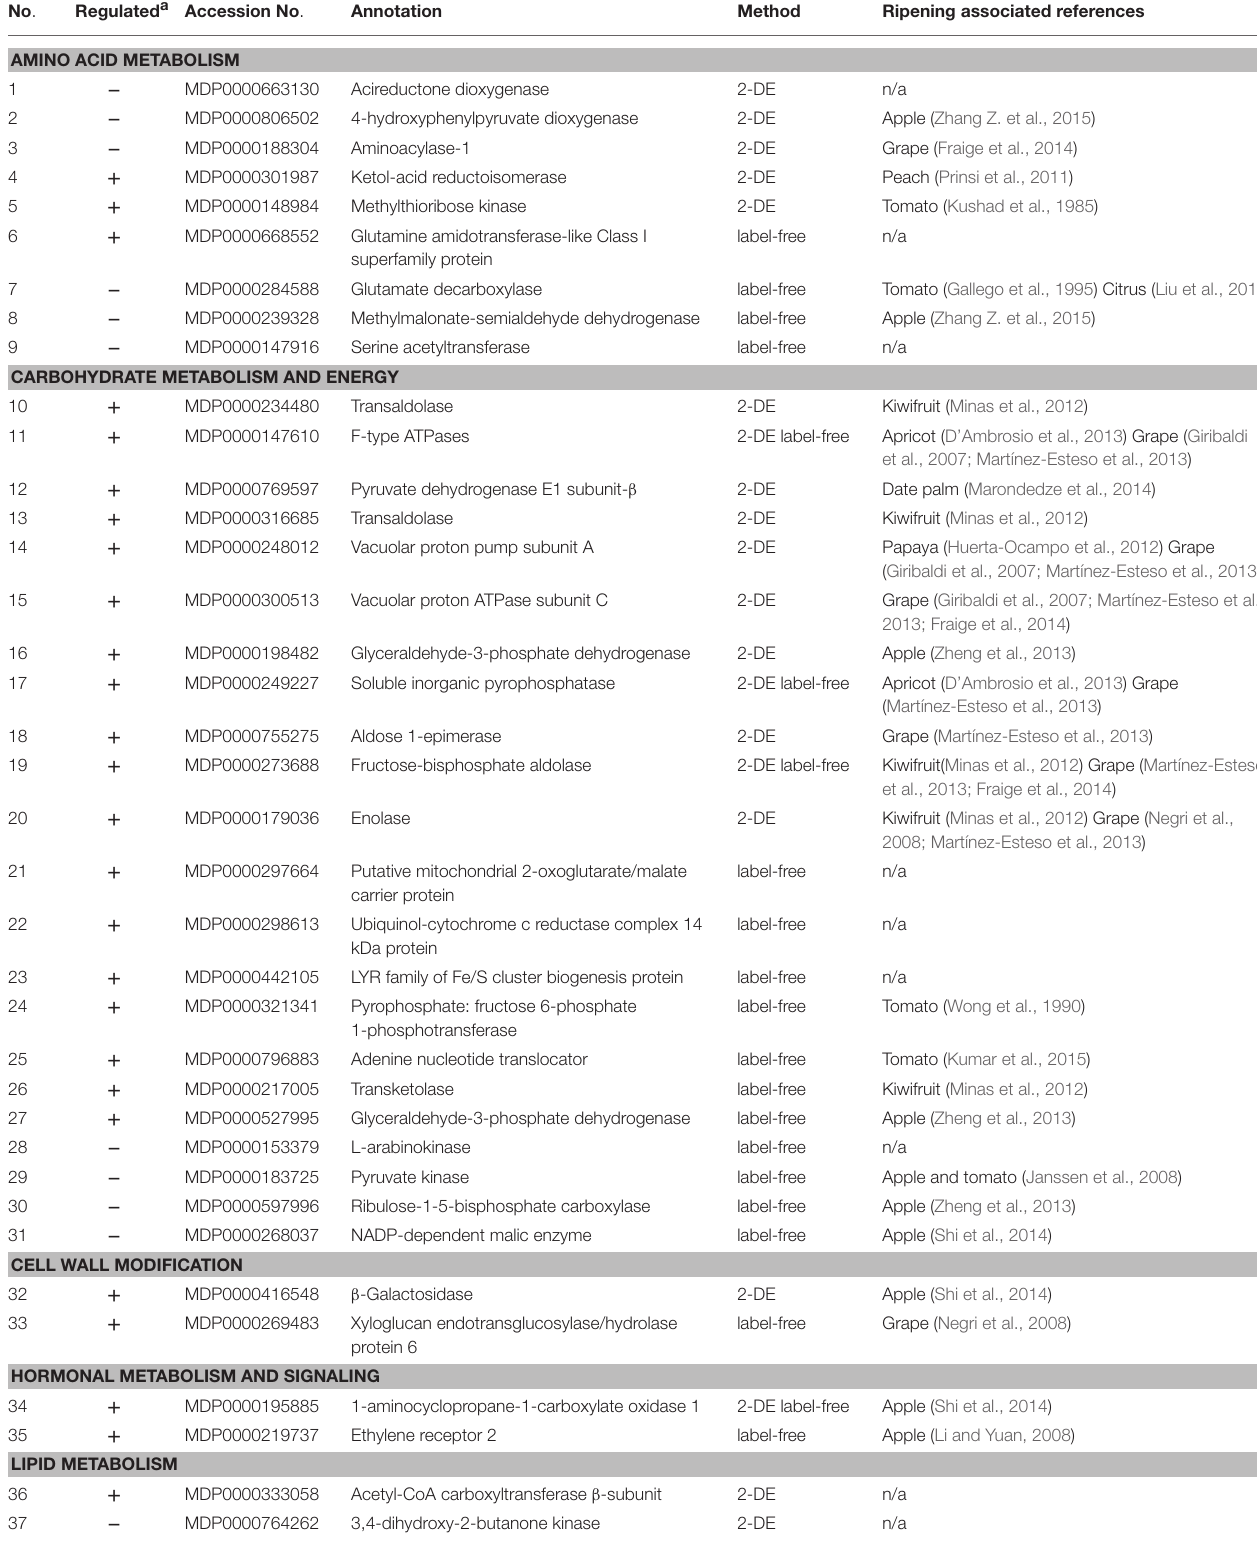
TABLE 1 | Differently expressed proteins obtained by 2-DE and label-free analysis in ALA-treated apple skin. No . Regulated a Accession No